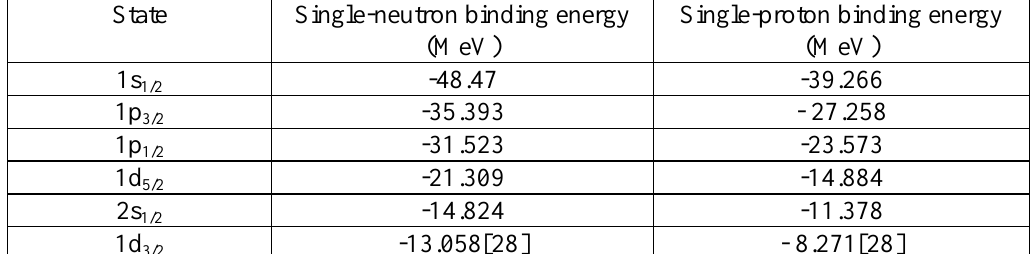
Table 7: Single-nucleon binding energies for 27